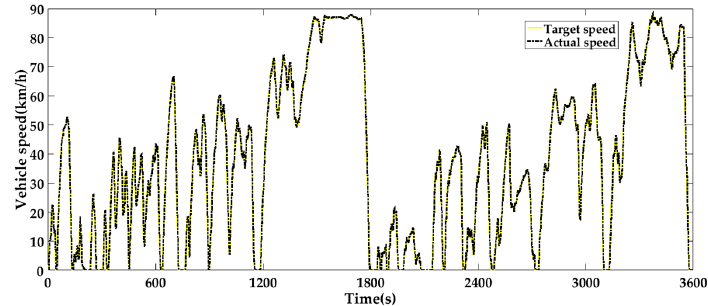
Figure 17. The actual speed and target speed under combined driving cycle.